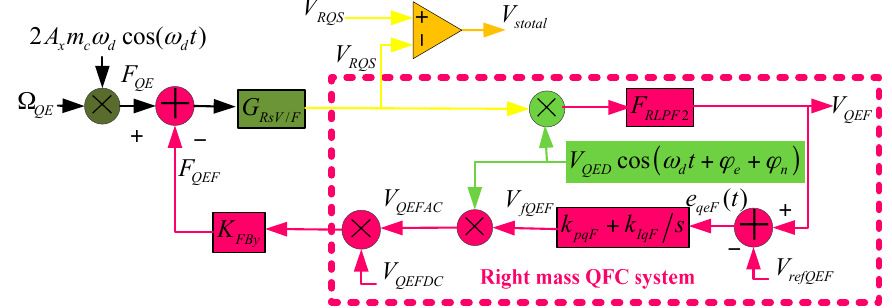
Figure 9. Right mass QFC system.